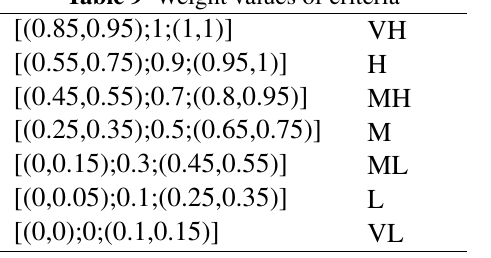
Table 9 Weight values of criteria